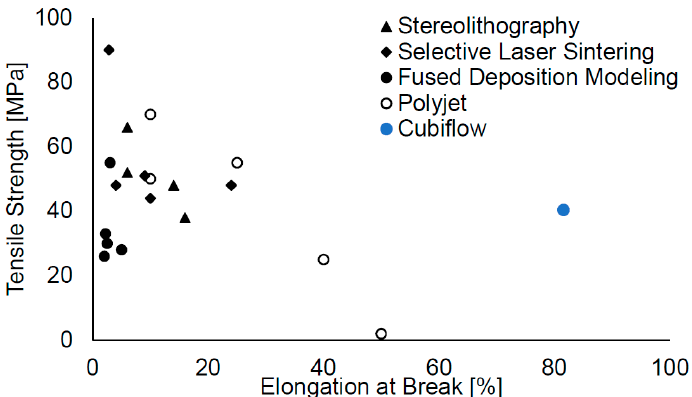
Figure 12. Comparison of the Cubiflow tensile strength and elongation at break results with values from other additive manufacturing polymer materials [2].